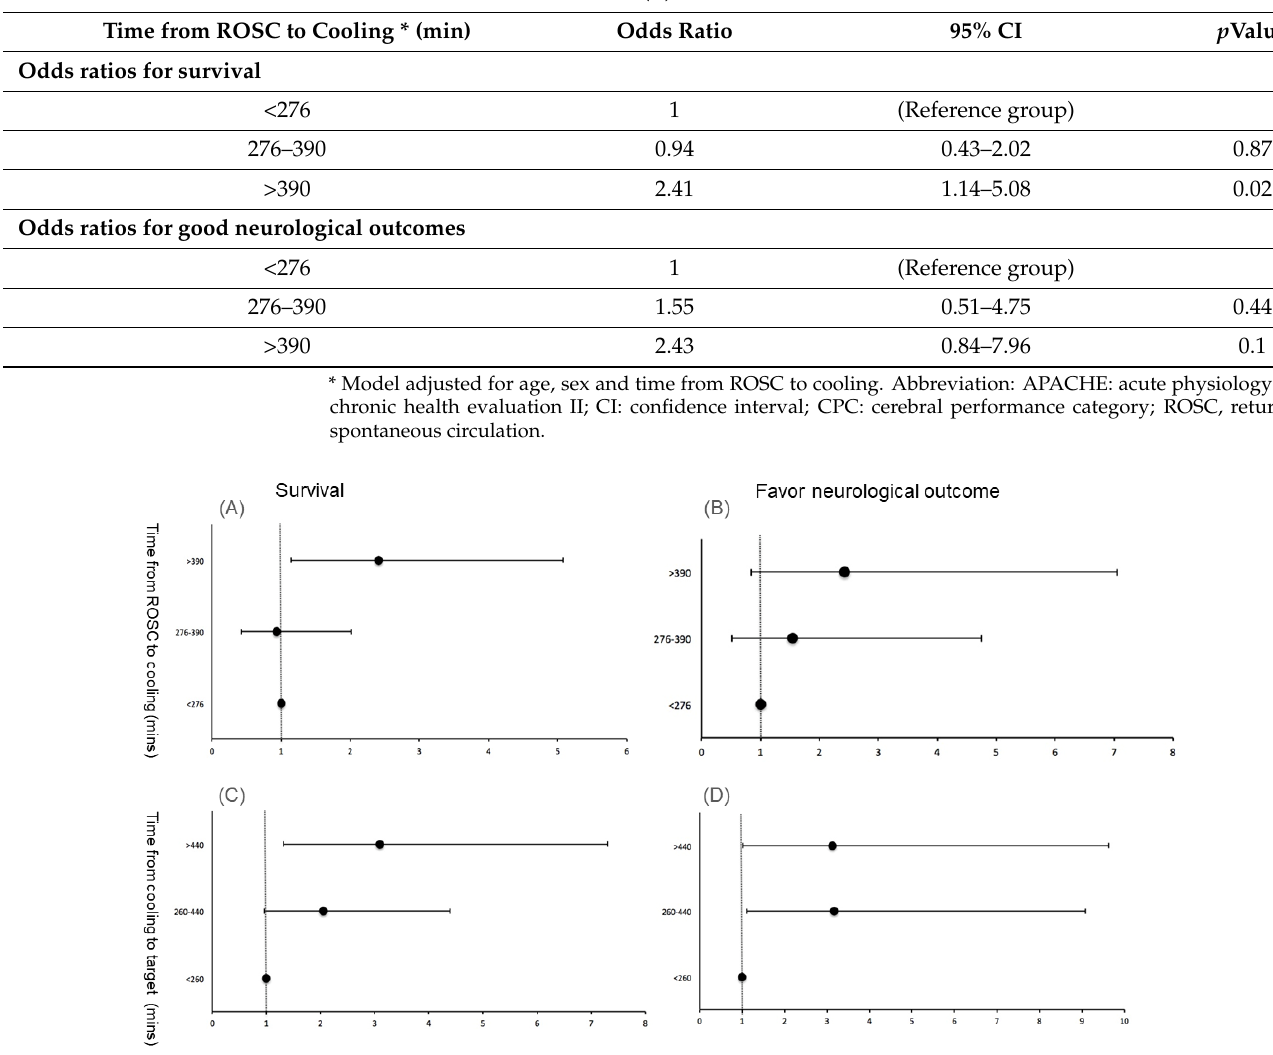
Figure 2. Adjusted odds ratio plot for survival and good neurological outcomes. ( A ) Time from ROSC to cooling for survival. ( B ) Time from ROSC to cooling for better neurological outcomes. ( C ) Time from cooling to target for survival. ( D ) Time from cooling to target for better neurological outcomes. Each black dots represent the odds ratio, and the horizontal line indicates the 95% confidence interval. Abbreviations: ROSC, return of spontaneous